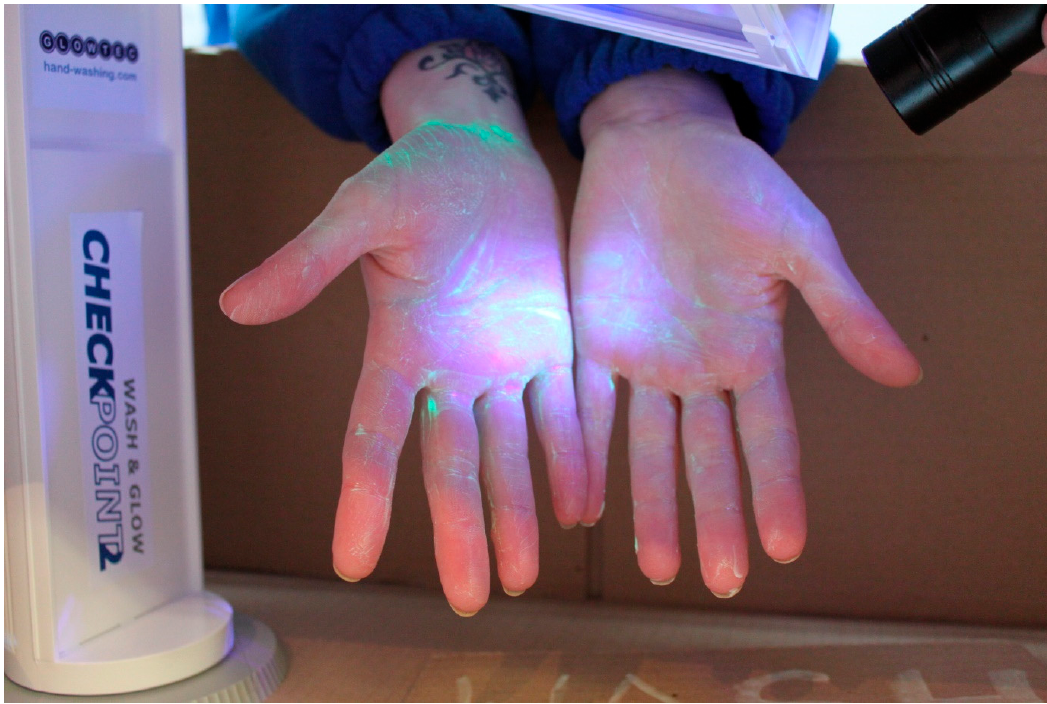
Figure 1. Activity one: ’Now wash your hands’: the audience engaged in hands-on activities focusing on the topic of hand hygiene. Here, a participant’s hands can be seen during the use of the UV glow gel.